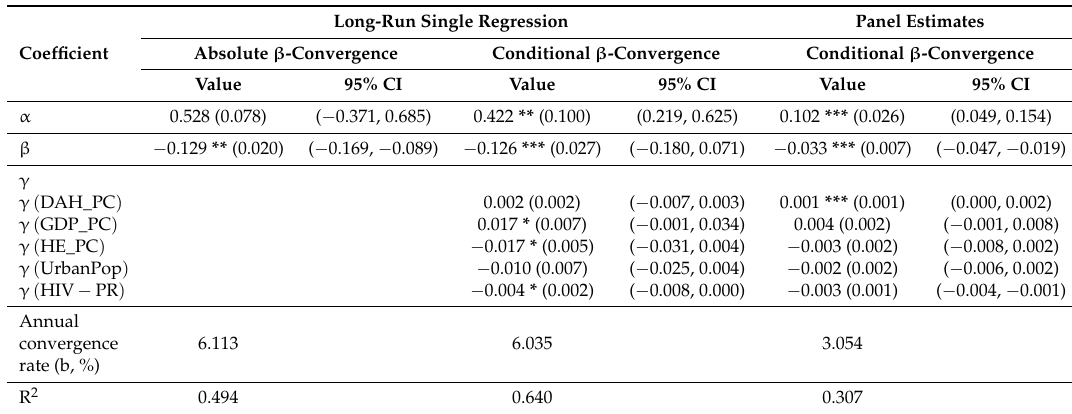
Table 2. Beta convergence analysis for LE, 1990–2011. 1,2,3,4